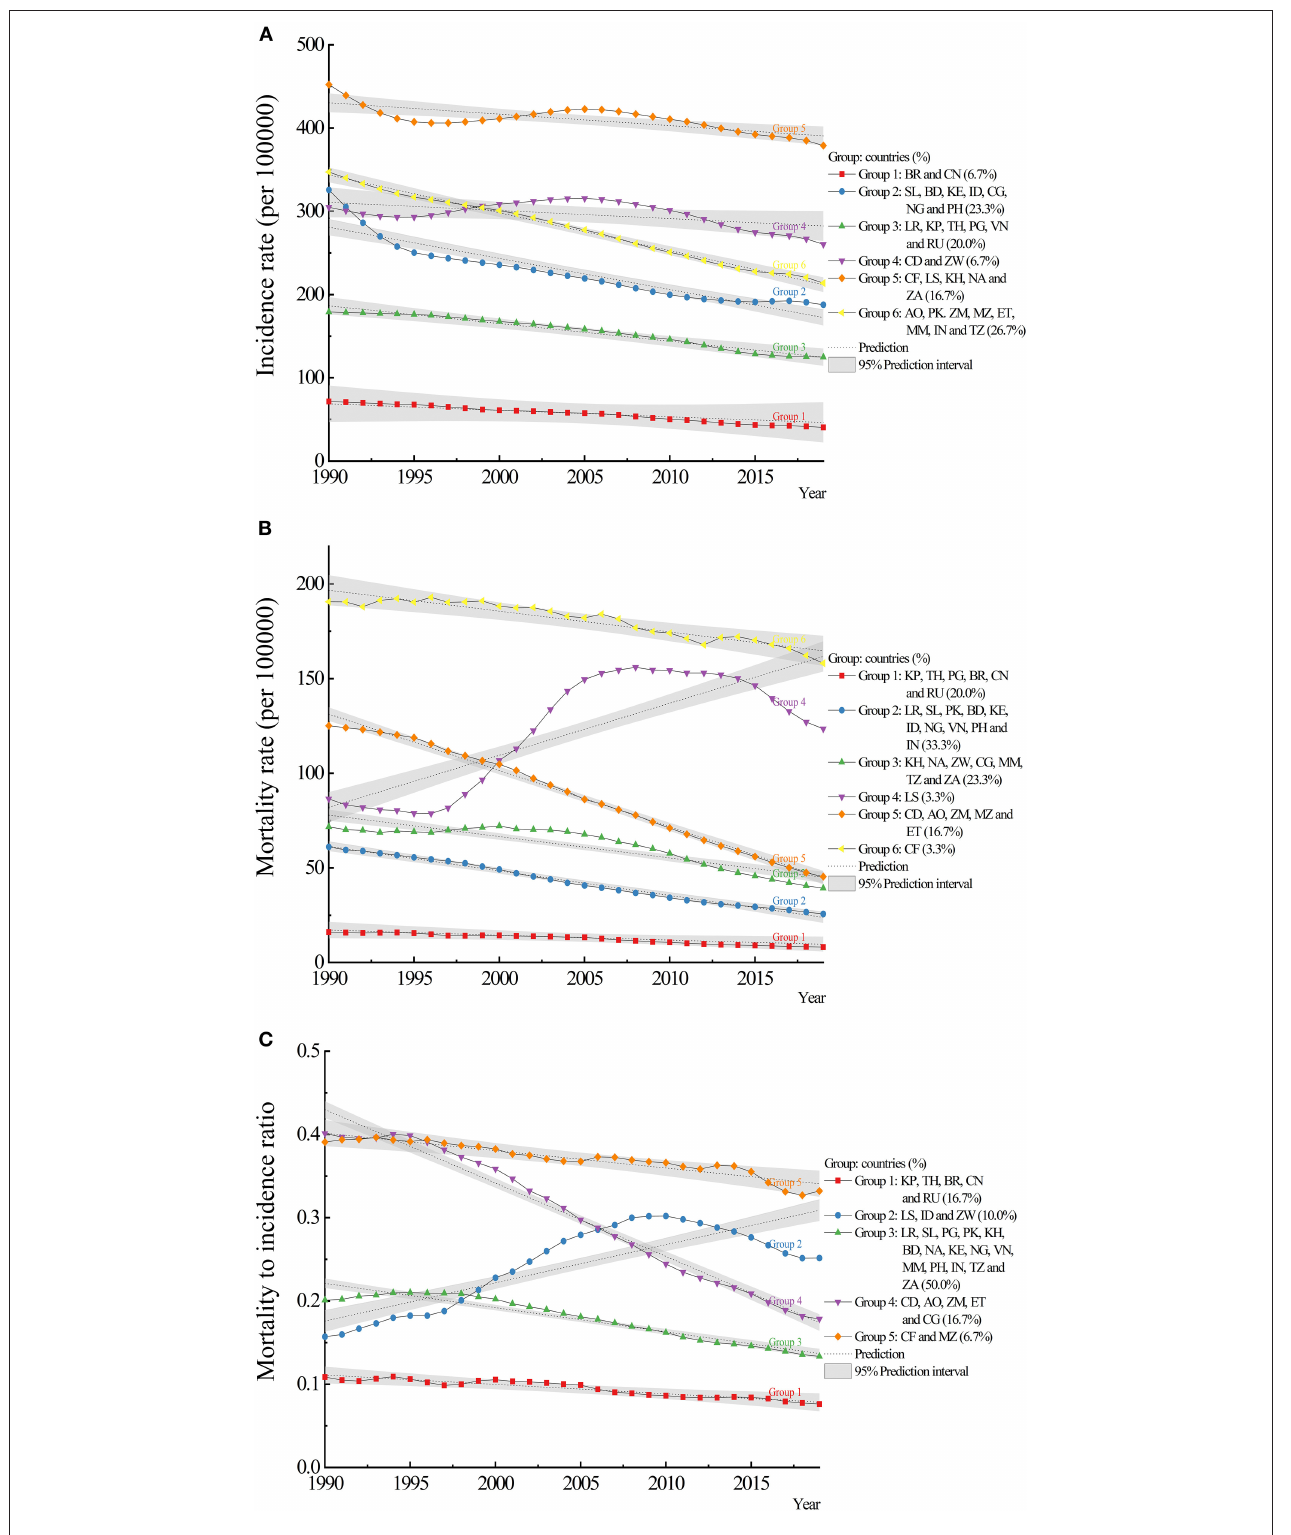
FIGURE 4 | Trajectory analysis of incidence, mortality, and mortality to incidence (MI) ratio of tuberculosis in the 30 HBCs: (A) incidence, (B) mortality, (C) MI ratio. HBC, high burden country; AO, Angola; BD, Bangladesh; BR, Brazil; KH, Cambodia; CF, Central African Republic; CN, China; CG, Congo; KP, Democratic